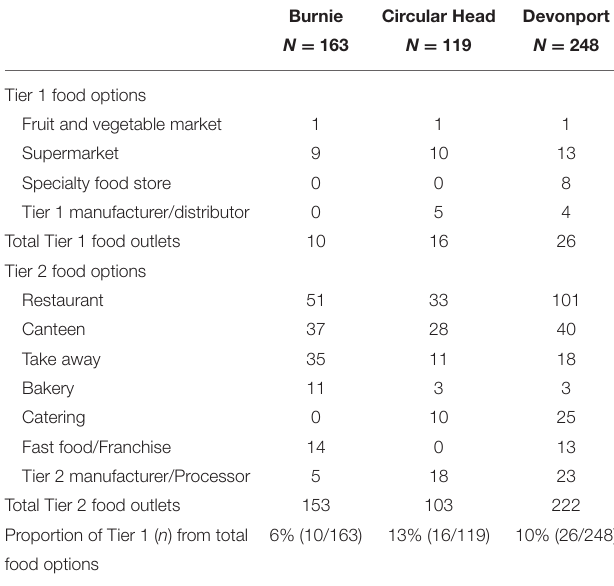
TABLE 2 | Variety of Tier 1/Tier 2 food outlets in Burnie, Circular Head, and Devonport. Burnie Circular